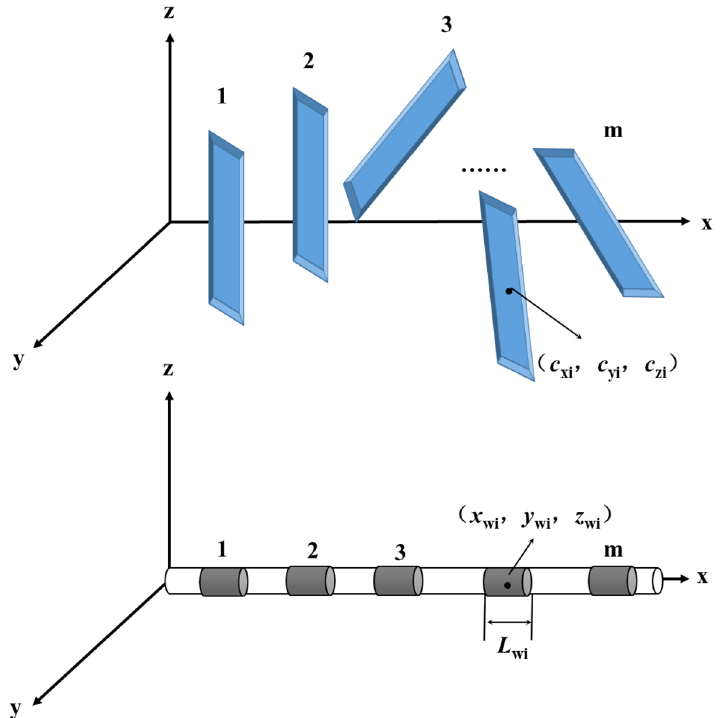
Figure 4. Schematic diagram of fracture distribution and horizontal section division of horizontal